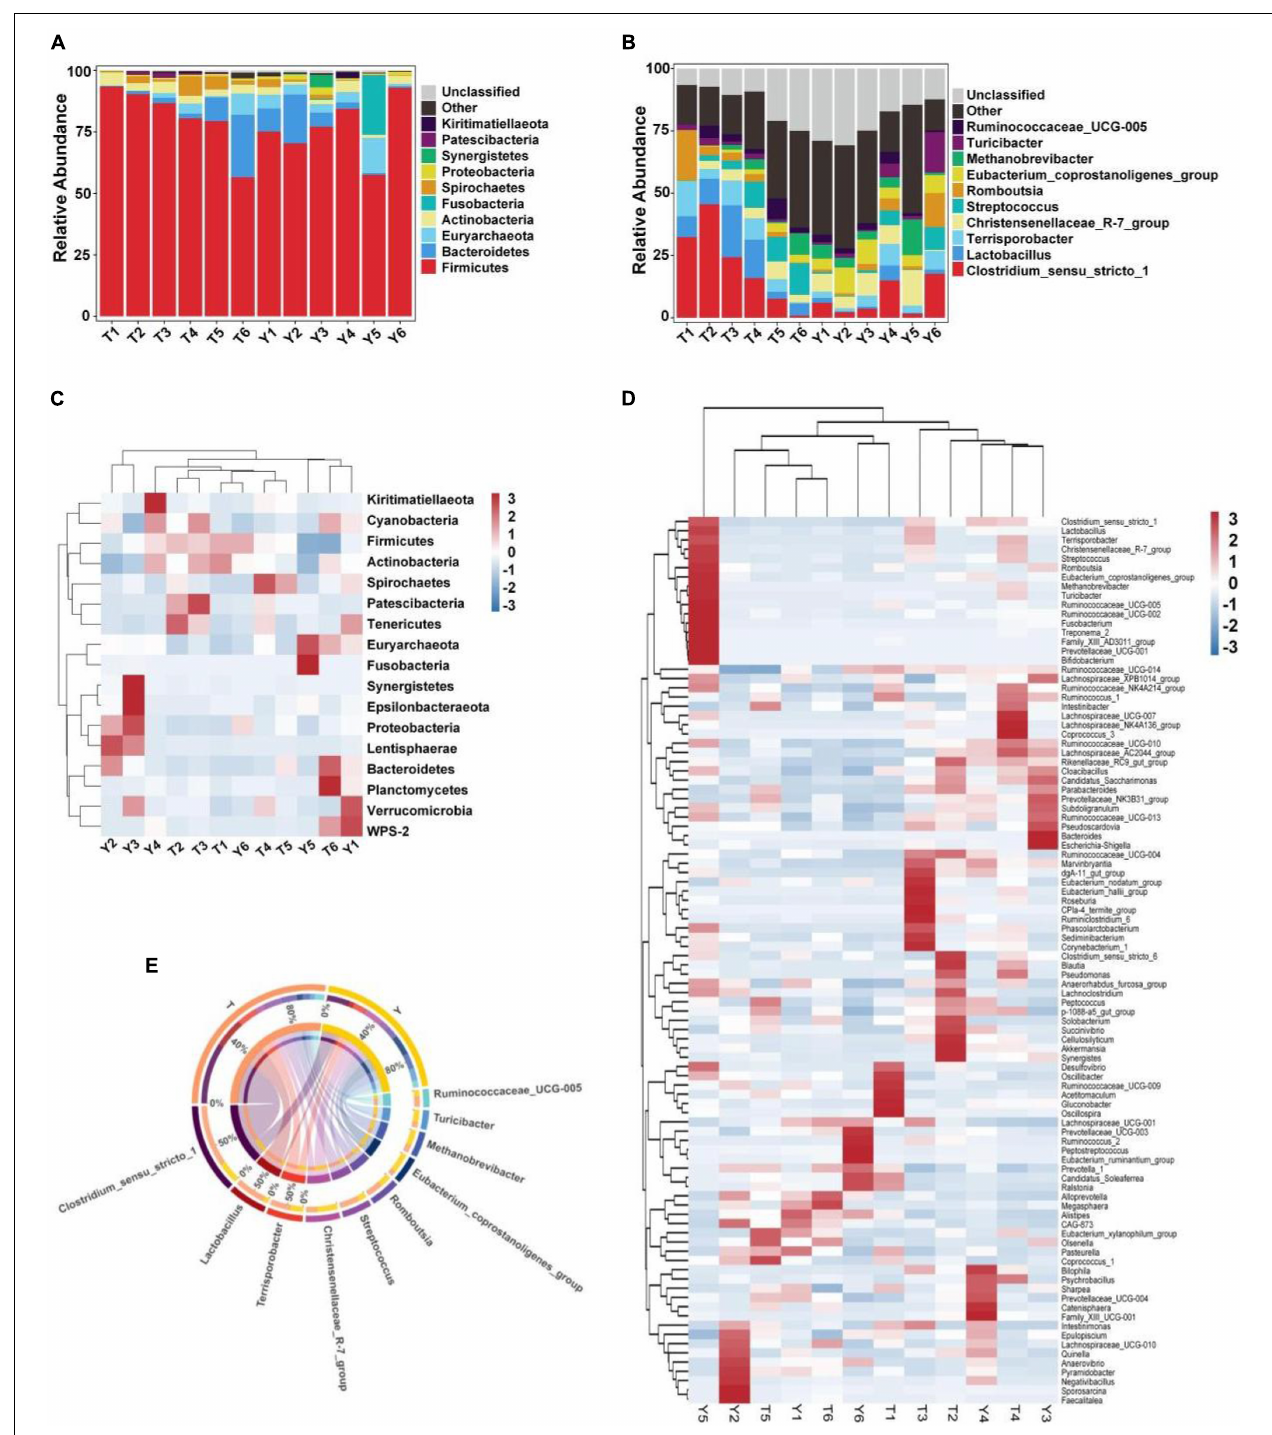
FIGURE 2 | Heat map showing the relative abundance of intestinal microflora in Tibetan and Yorkshire pigs at phylum and genus level. (A,B) Represent the distribution at the phylum and genus level, respectively. (C) Heat maps of the 17 most common gates in different communities. (D) Heat maps of the 96 most common genera in different communities. Each color block in the heat map represents the relative abundance of a genus in the sample. Clustering can distinguish taxon with different abundance, and color gradient and similarity can reflect the similarities and differences of multiple samples at different classification levels. The blue-red gradient shows the change of abundance from low to high. (E) Composition of microorganisms among horizontal species.